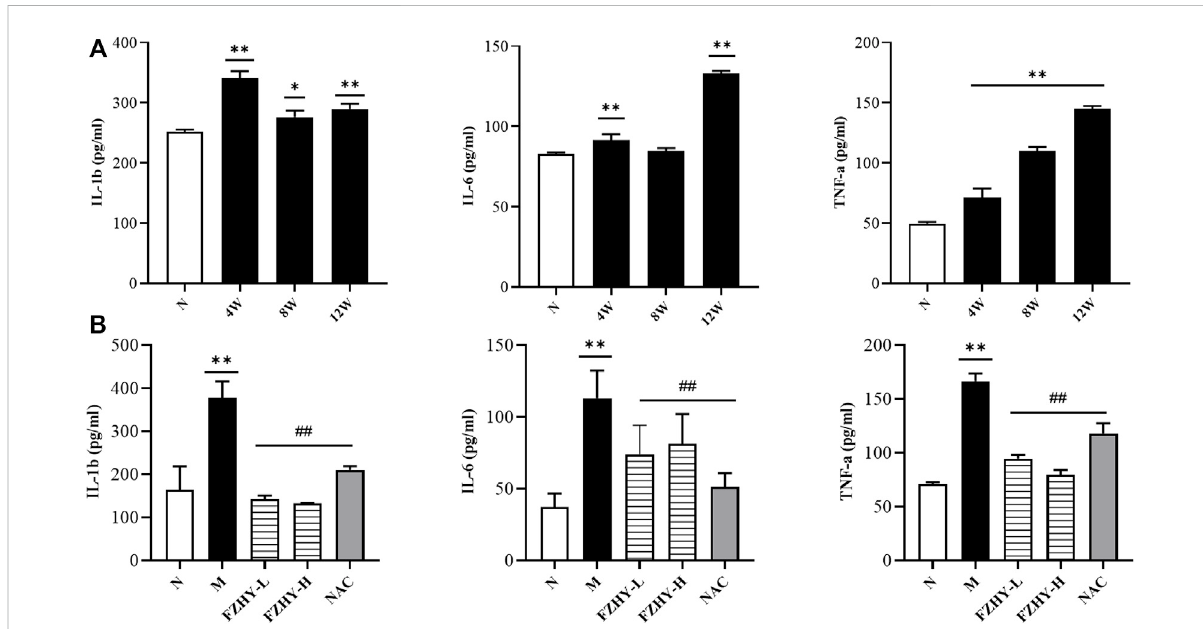
FIGURE 7 Enzyme-linked immunosorbent assay (ELISA) analyses demonstrate the changes of in fl ammatory response during FZHY against renal fi brosis. Dynamic experimental model mice were intraperitoneal injected with Aristolochic Acid I (AAI) (4 mg/kg body weight) twice a week and sacri fi ced at 4 weeks, 8 weeks, and 12 weeks. Pharmacodynamicexperimentalmodel mice wereintraperitoneal injected with AAI (4 mg/kgbody weight)twice a week for 12 weeks. From the fourth week of AAI injection, mice were intragastrically administered FZHY (1.44 g/kg, 2.88 g/kg body weight) or NAC(3.0 g/kgbodyweight)perdayfor8 weeks.Allmiceweresacri fi ced.ELISAanalysiswasemployedtodetectin fl ammatoryfactors.Levelsof IL-6 , IL-1 β , and TNF- α signi fi cantly increased after AAI administration (A) , and levels of IL-6 , IL-1 β , and TNF- α decreased after FZHY (B) .